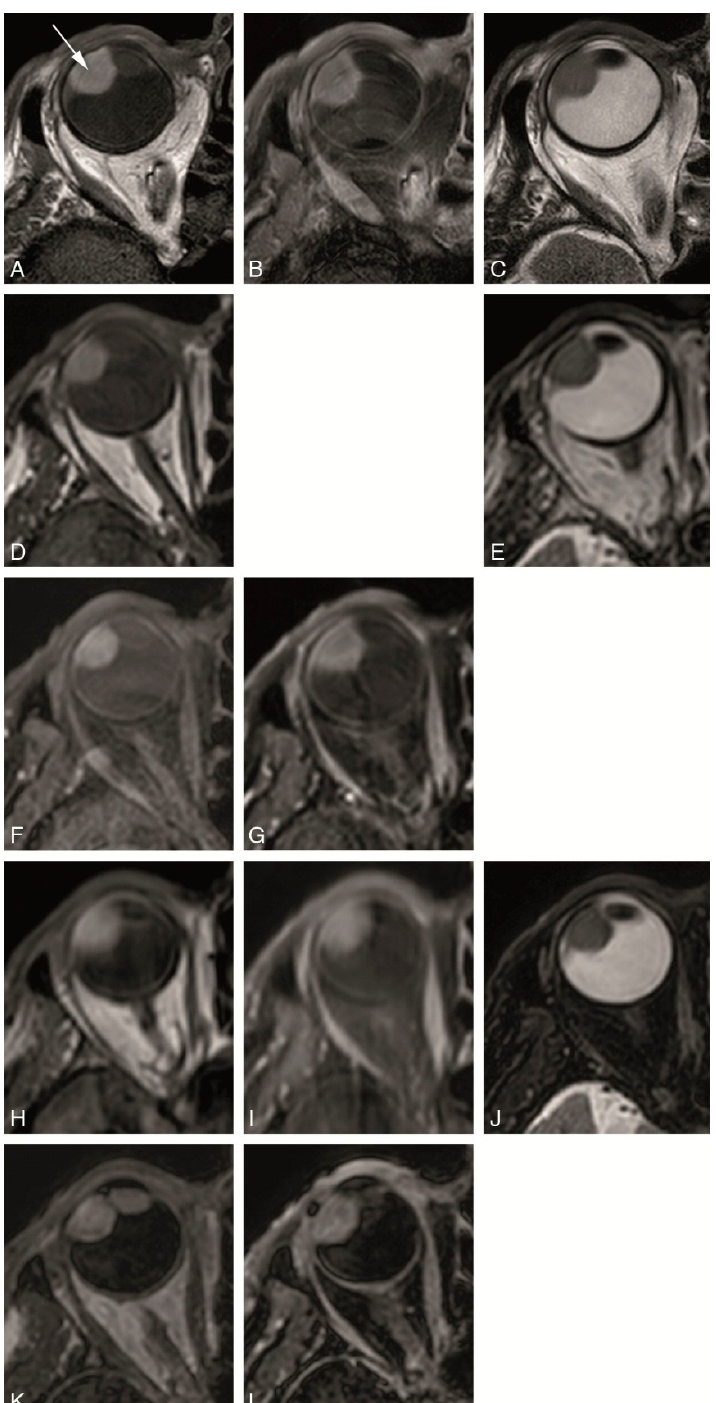
Figure 2. ( A – L ) Study protocol: Multiple anatomical axial MRI sequences in a patient with a uveal melanoma of the right eye (arrow). ( A ) MS 2 mm T1. ( B ) MS 2 mm enhanced T1 with fat signal suppression. ( C ) MS 2 mm T2. ( D ) MS 1 mm T1. ( E ) MS 1 mm T2. ( F ) MS 1 mm T1 with fat signal suppression. ( G ) MS 1 mm enhanced T1 with fat signal suppression. ( H ) 3D TSE 1 mm T1. ( I ) 3D TSE 1 mm enhanced T1 with fat signal suppression. ( J ) 3D TSE 0.8 mm T2 with fat signal suppression. ( K ) 3D TFE 0.8 mm T1. ( L ) 3D TFE PROSET 0.8 mm enhanced T1 with fat signal suppression.